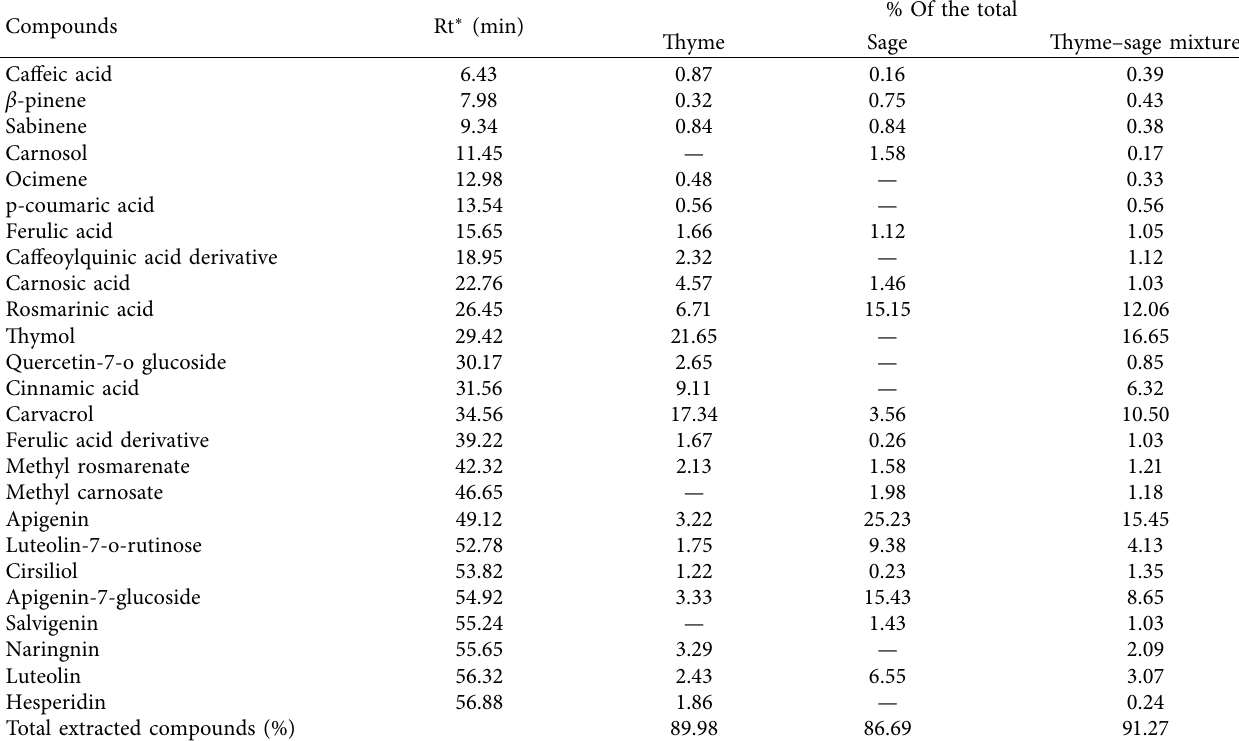
Table 2: Phenolic compounds of thyme, sage, and thyme–sage mixture methanolic extract.